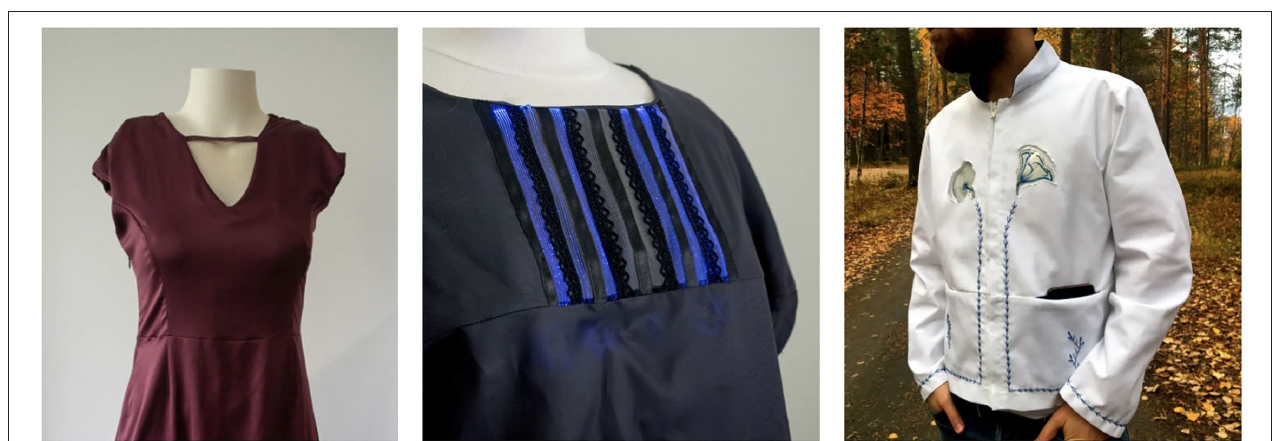
FIGURE 4 | Examples of the authors’ works in smart clothing and textiles. L-R: Linn Dress, Idle Stripes shirt, DecoLive